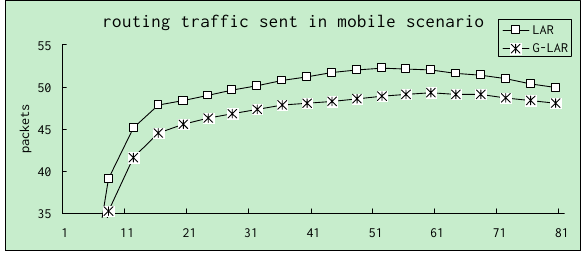
Fig. 9. Acknowledgement sent in stationary scenario